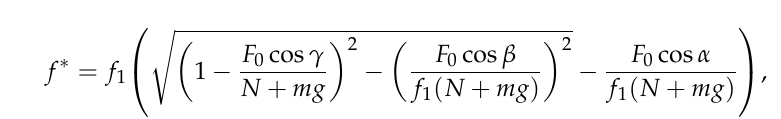
Figure 5. Vibration force projects in the first and the third quadrants.